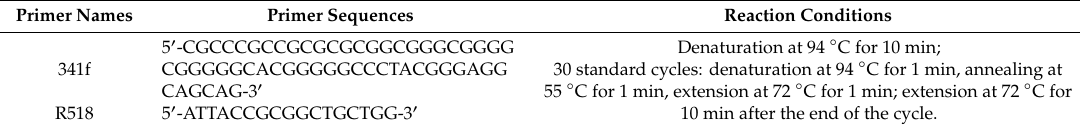
Table 1. The primers and reaction conditions for the PCR